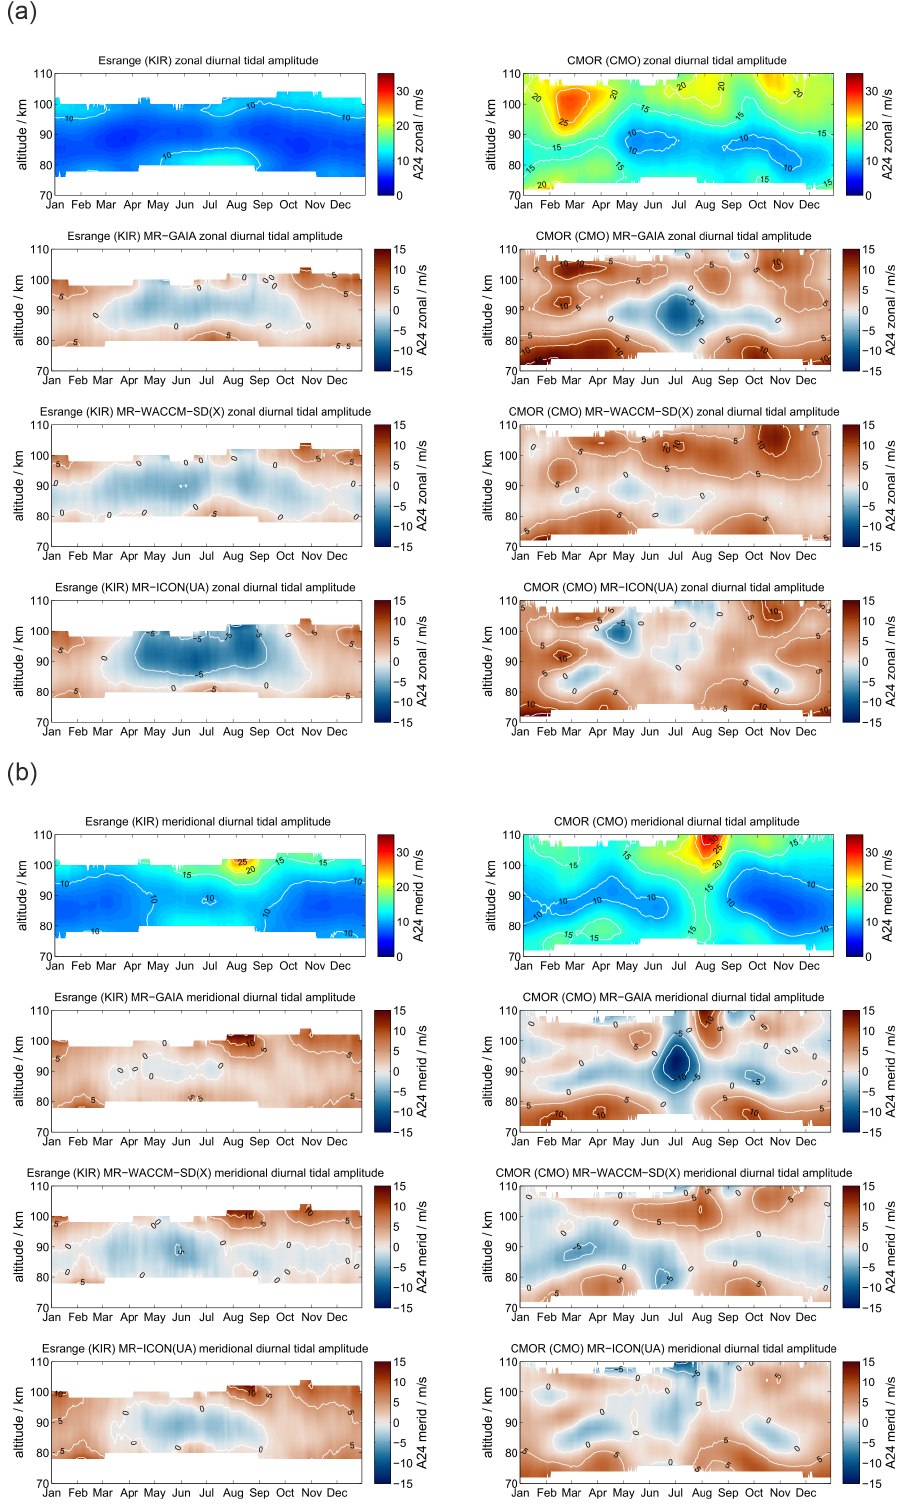
Figure C3. The same as Fig. C1, but for KIR and